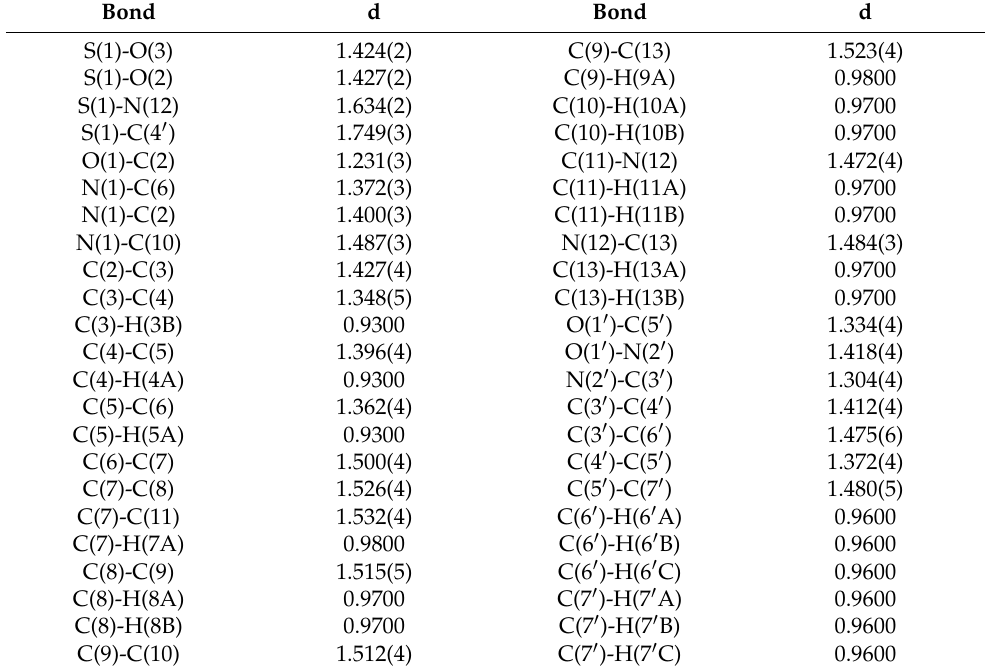
Table 1. Bond lengths (d, Å) in molecule 2 .